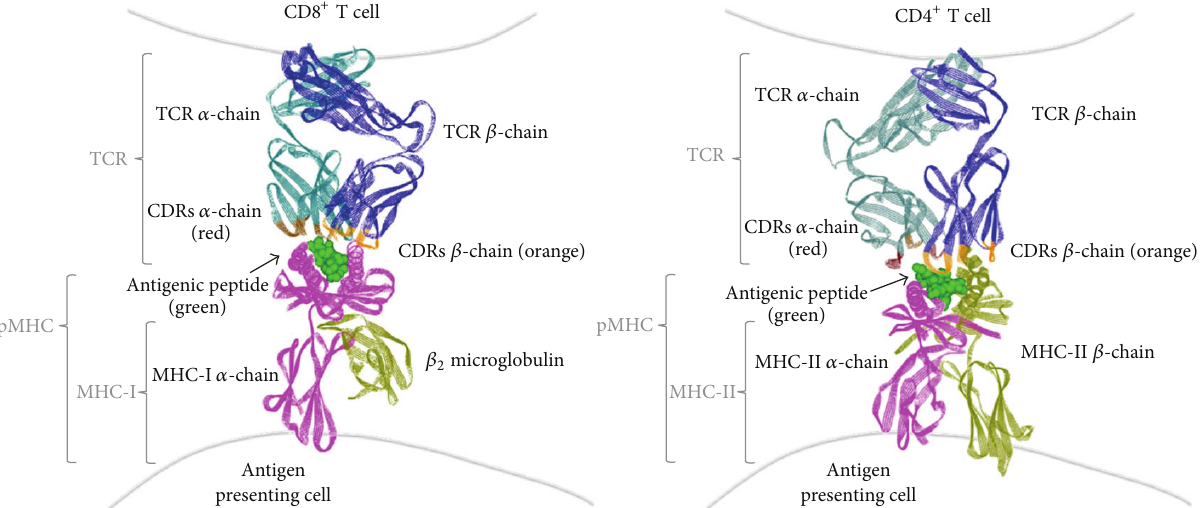
Figure 1: The structure of the T cell receptor (TCR) and its ligand, the peptide-MHC complex (pMHC). The TCR is a disulfide-bound heterodimer composed by one alpha (dark green) and one beta (blue) chain. Diversity within TCR molecules is mainly concentrated at the complementarity determining regions (CDRs, in red and orange) of the alpha and beta chains at the antigen-recognition region. Antigenic peptides are presented in the peptide groove of MHC molecules. MHC-I molecules are composed by an alpha chain (pink) that harbors the peptide-presentation groove and a small beta-2 microglobulin chain (yellow, 𝛽 2 m). On the other hand, MHC-II molecules are composed by one alpha (pink) and one beta (yellow) chain. As shown for this molecule, the peptide-presentation groove in these molecules is formed by both chains. Antigenic peptides (green) have amino acids that are exposed to the TCR molecule and amino acids that are buried within the MHC groove. Left: the TCR/pMHC complex of a human melanoma-specific TCR (DMF5) bound to MHC-I HLA-A2 with the the MART-1 (26–35)peptide(RCSBProteinDataBankaccessionnumberDOI:10.2210/pdb3qdg/pdb,3QDG).Right:theTCR/pMHCcomplexofahuman melanoma-specific TCR (E8) bound to the MHC-II molecule HLA-DR1 and an epitope from mutant triosephosphate isomerase (RCSB Protein Data Bank accession number DOI: 10.2210/pdb4e41/pdb, 4E41). Both molecules were modeled using the software ViewerLite 5.0 from Accelrys